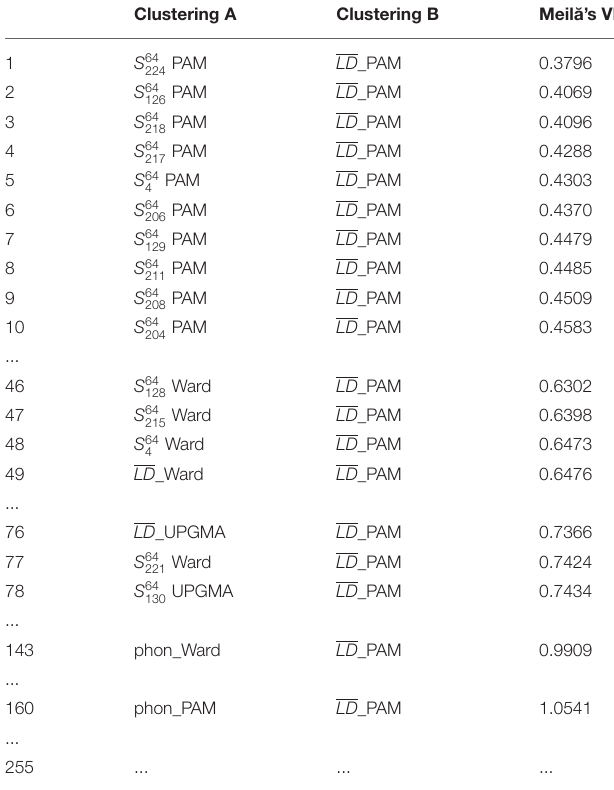
TABLE 2 | Meil˘a’s VI values, comparing the cluster partitions across linguistic distance matrices of S subsets and cluster partitions of LD using the three clustering methods, PAM, UPGMA, and Ward’s